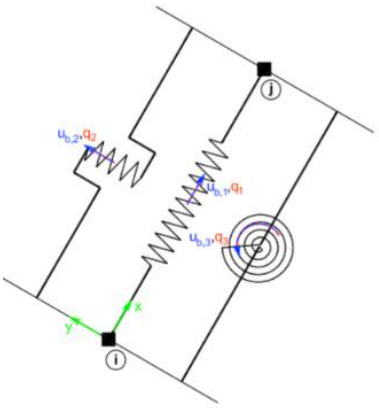
Figure 11. Two Node Link Element in OpenSees.